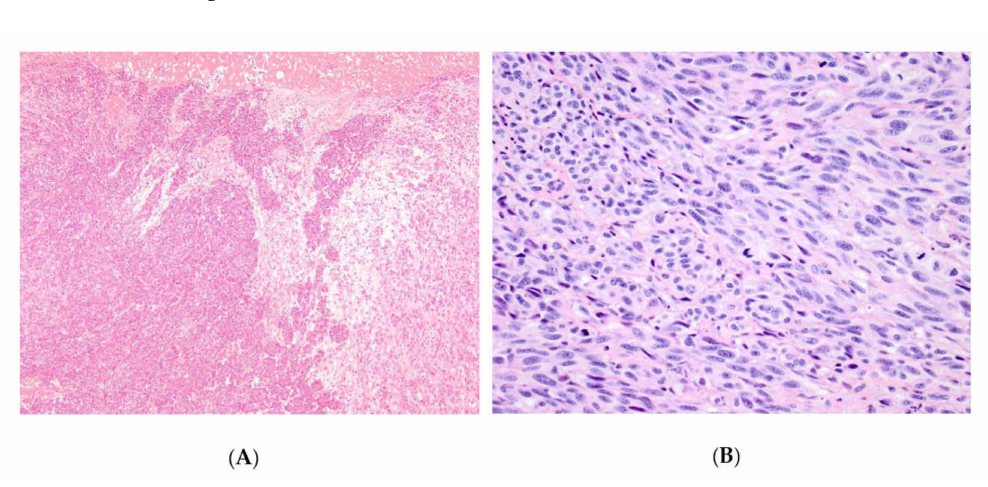
Figure 1. Ulceration in an anorectal melanoma ( A ) and prominent mitotic figures in another invasive vulvar melanoma ( B